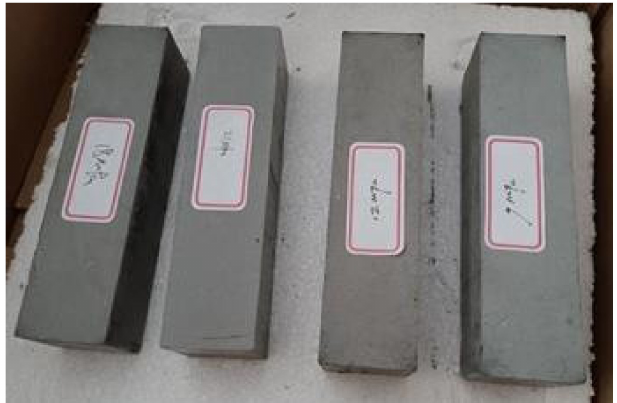
Figure 4. Non-fired